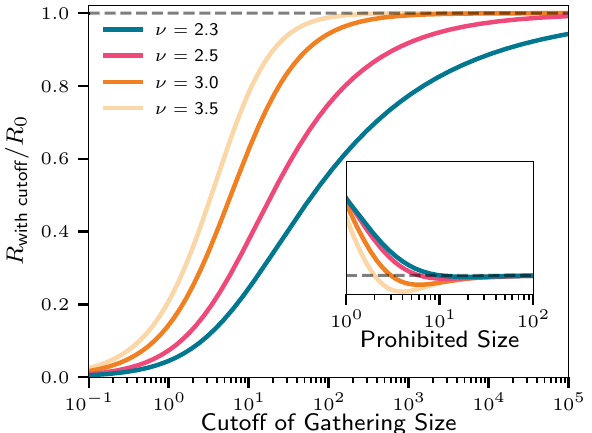
Figure 5. Effect of mitigation by banning gatherings. Curves shows the fractional change in R 0 as a function of a cutoff size, larger than which gatherings are disallowed. Inset shows the effect of bans of a specific size, dashed line indicating the line of no change. The scale of the y -axis is arbitrary in the inset as we are considering a ban on an infinitesimally small range of location sizes. Also note that the cutoff can be fractional in that we consider the average number of interactions at a